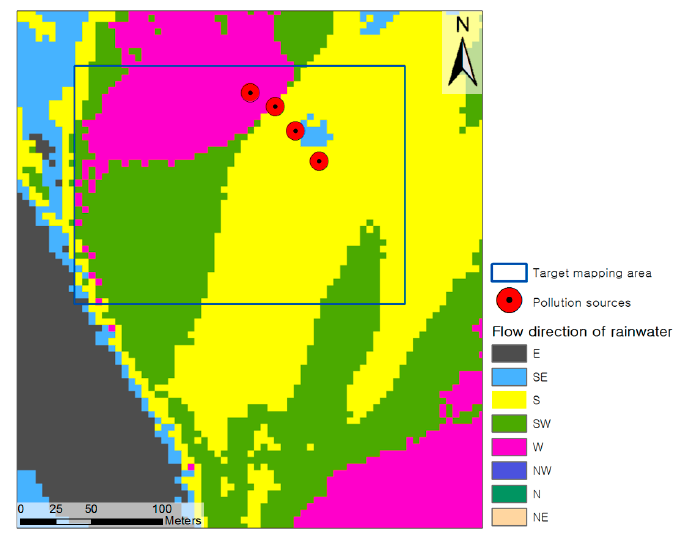
Figure 8. Flow direction of rainwater in the study area.